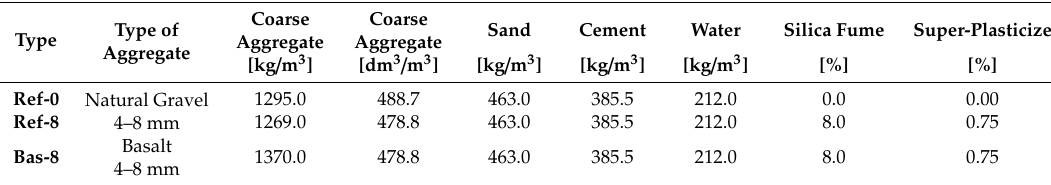
Table 2. Concrete recipes prepared for